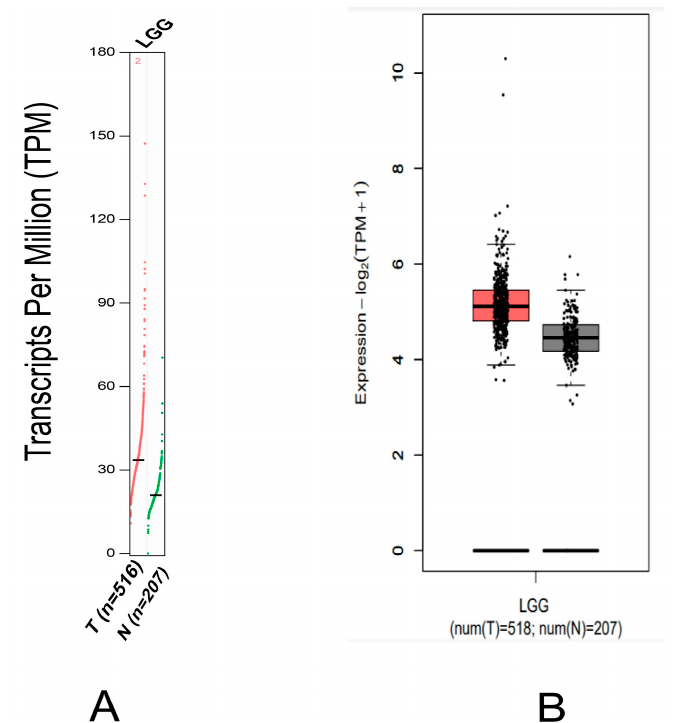
Figure 3. MDM2 gene expression profile by tissue in LGG derived from the GEPIA2 database, where T denotes the tumor tissue and N is depicted for the normal tissue. ( A ) MDM2 gene expression in LGG, depicted as a box plot with the red box representing tumor samples and the black box representing normal samples. ( B ) GEPIA2 database was also used to compare the transcription pattern of MDM2 in brain lower-grade glioma (LGG) patients with their respective normal samples. The rate of promoter methylation in MDM2 gene was greater in brain cancer com- pared to the standard tissues based on sample type, different cancers stages, ethnic back- ground, sex, weight, age, histopathologic subtypes, and TP53 mutation status. The level of methylation of MDM2’s promoter in LGG was determined and exhibited in Figure 4 and Supplementary Table S3.